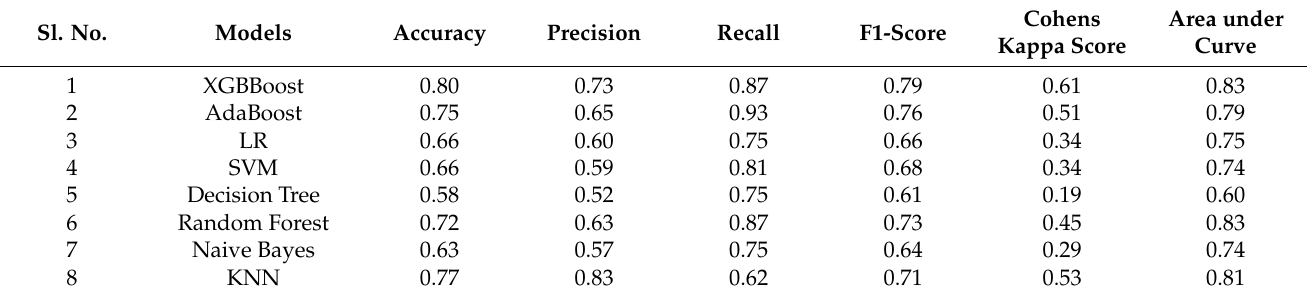
Table 2. The efficiency of the models used in ML-DTD. ML-DTD uses six parameters: Accuracy, Precision, Recall, F1-Score, Cohens Kappa Score, and Area Under Curve (AUC) to estimate the overall